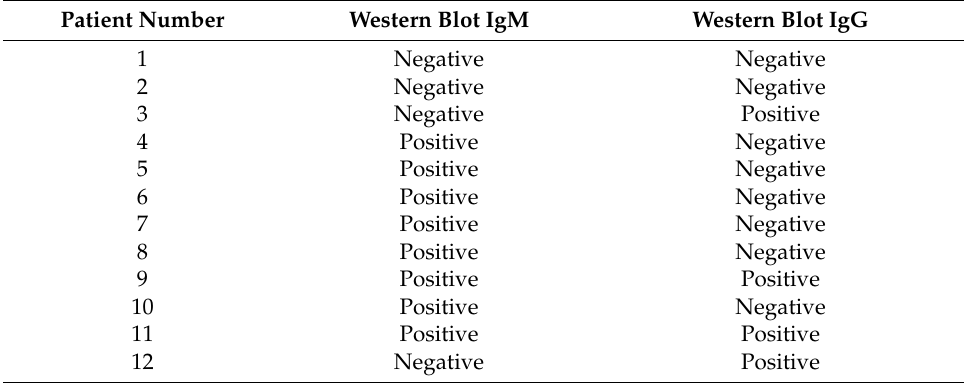
Table 2. Lyme Western Blot IgM and IgG Results in Study